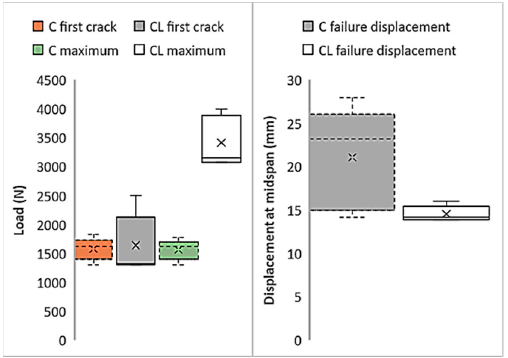
Figure 15. Critical points of the M60 composite’s flexural test results.